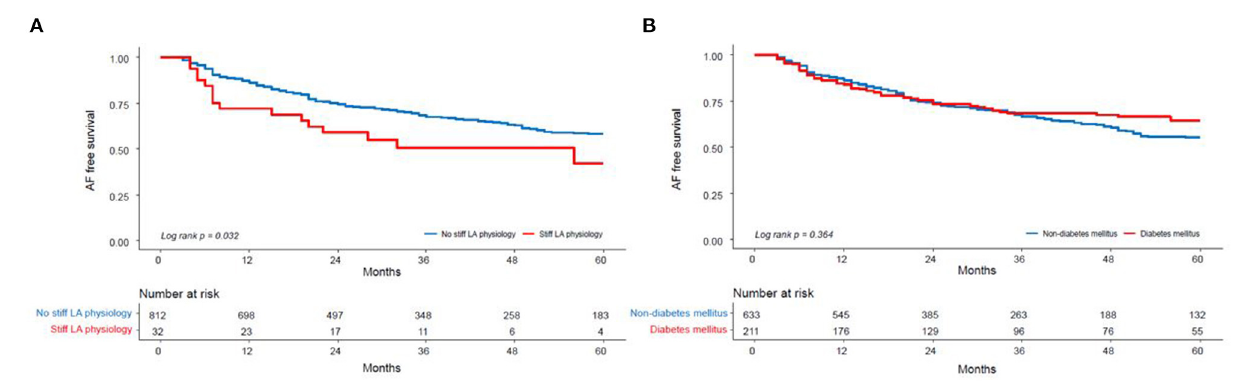
FIGURE 3 | Kaplan–Meier analysis of the clinical recurrence of AF after AFCA (A) according to the presence of a stiff LA physiology and (B) DM. LA, left atrium; DM, diabetes